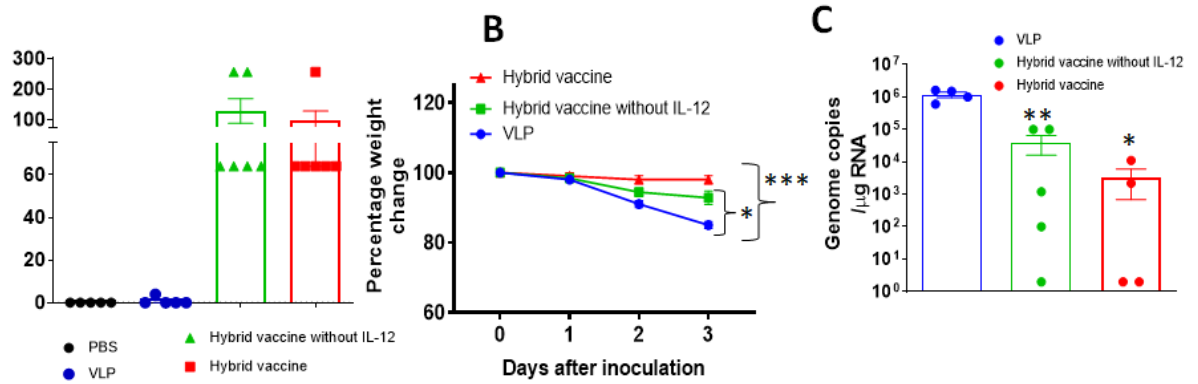
Figure 5. Hybrid vaccine protects against SARS-CoV-2 challenge. BALB/c mice ( n = 10; 2–3 months old) were administered with a hybrid vaccine, a hybrid vaccine without IL-12 or VLP in 50 ul volume via an intramuscular route. Control mice received either PBS or influenza VLP. A booster dose was given on d33 and blood was collected 2 weeks later (week 7). Mice were challenged with mouse-adapted SARS-CoV2 ( n = 5) 16–18 weeks after the first dose. ( A ) Neutralizing antibody titers in the serum of BALB/c mice ( n = 5–6 per group). Serum collected from BALB/c mice 2 weeks after the booster dose was serially diluted from 1:4 to 1:1024, and PRNT was conducted against SARS-CoV-2 (Wuhan virus). ( B ) BALB/c mice were inoculated intranasally with mouse-adapted SARS-CoV-2 (10 5 plaque-forming units) 3 months after the booster dose. Percentage of daily body weight change in the animals. ( C ) The RNA levels of SARS-CoV-2 were determined in the lungs by qRT-PCR ( n = 4–5 per group). Error bars represent SEM. The data are expressed as genome copies/ µ g of RNA. Each data point represents an individual mouse. Data are expressed as mean log 10 titer. For body weight changes, a two-way analysis of variance (ANOVA) with the post hoc Bonferroni test was used to calculate values of p. Mann–Whitney test was used to calculate the p values of the difference between viral titers. Differences of p < 0.05 were considered significant. * p < 0.05; ** p < 0.01 *** p < 0.001. Hybrid vaccine: VLP incorporated with GPI-RBD-GM-CSF and